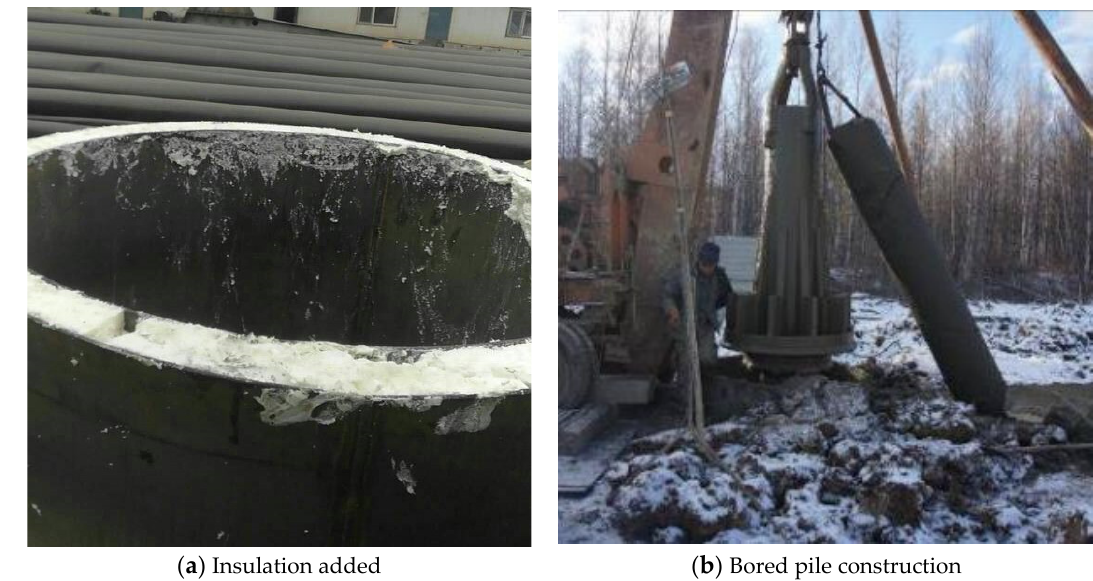
Figure 3. The construction site situation.